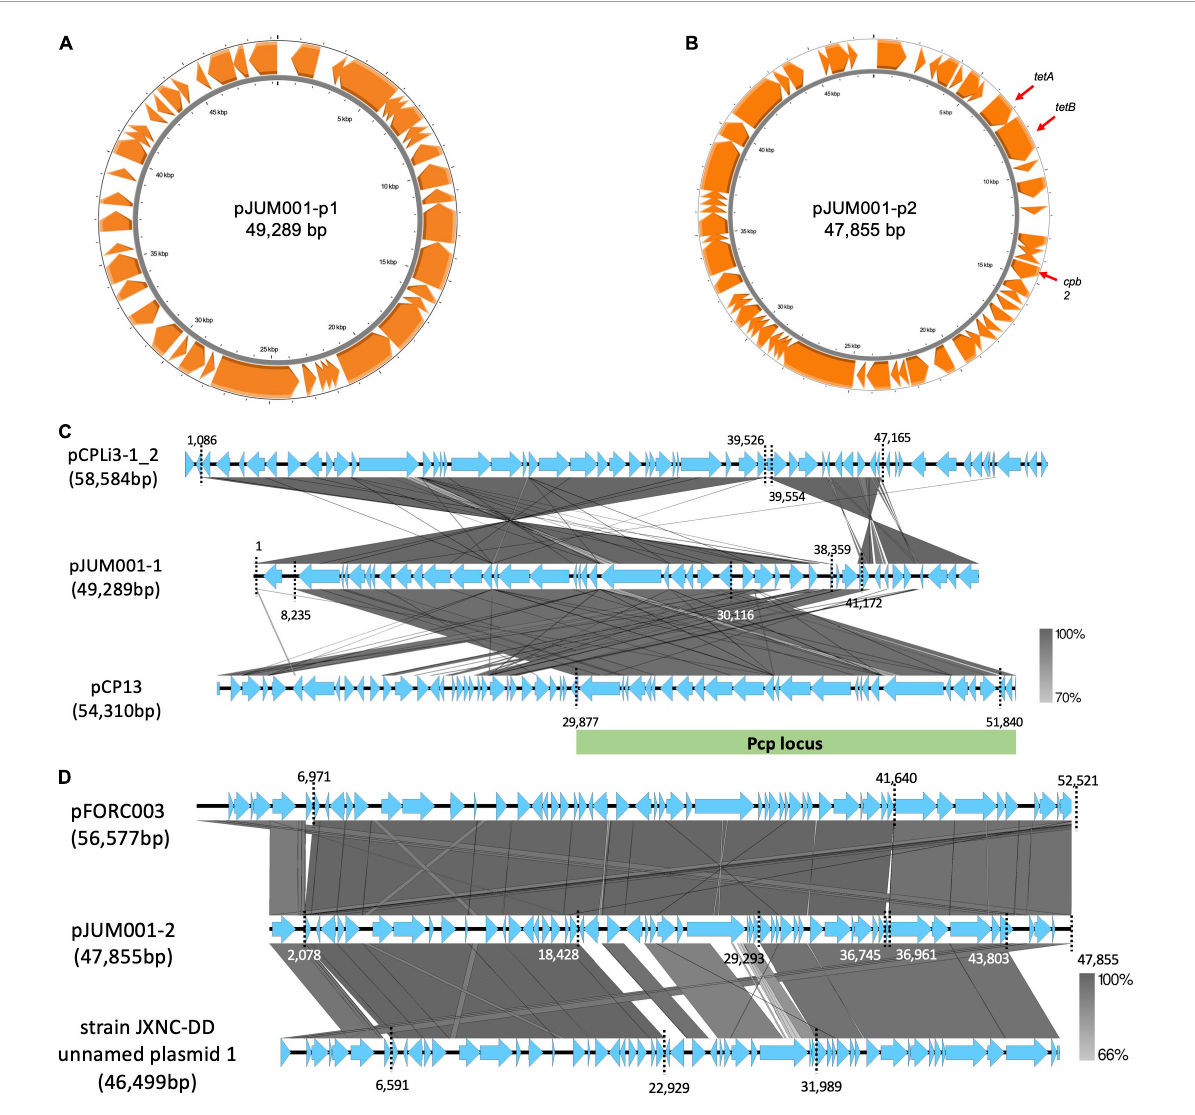
FIGURE3 Genetic structures of the two plasmids, pJUM001-1 and pJUM001-2. (A) Circular structure of pJUM001-1. The figure was generated using the Proksee online tool. Genes are indicated in orange. (B) Circular structure of pJUM001-2. The figure was generated using the Proksee online tool. Genes are indicated in orange. (C) Comparison of the plasmid pJUM001-1 with the plasmids pCPLI3-1_2 and pCP13. Homologous regions are shaded in gray, with the percentage identity shaded according to the bar. The Pcp locus is indicated as green bar. (D) Comparison of the plasmid pJUM001-2 with the plasmids pFORC003 and JXNC unnamed plasmid 1. Homologous regions are shaded in gray, with the percentage identity shaded according to the